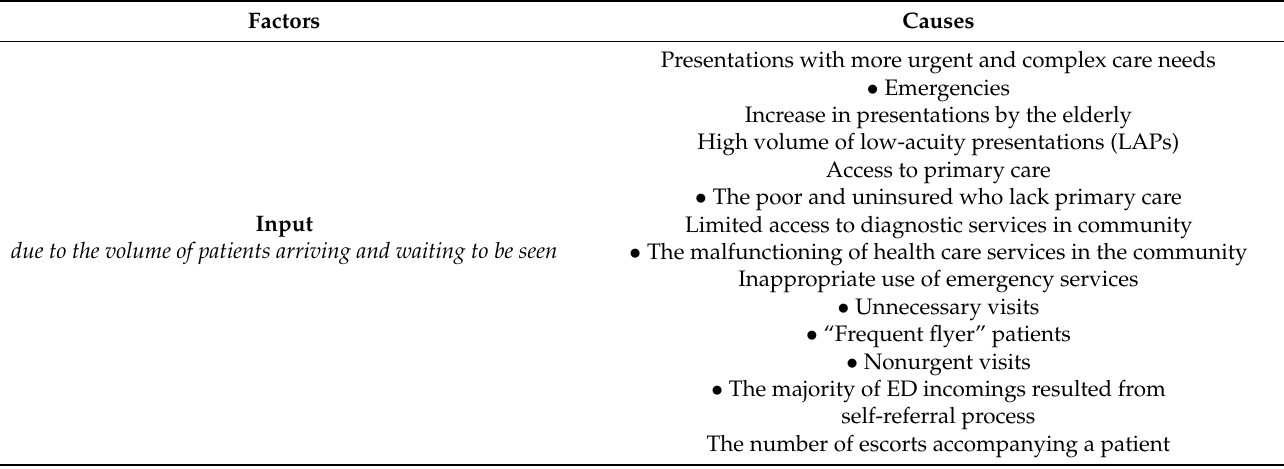
Table 2. Main causes of